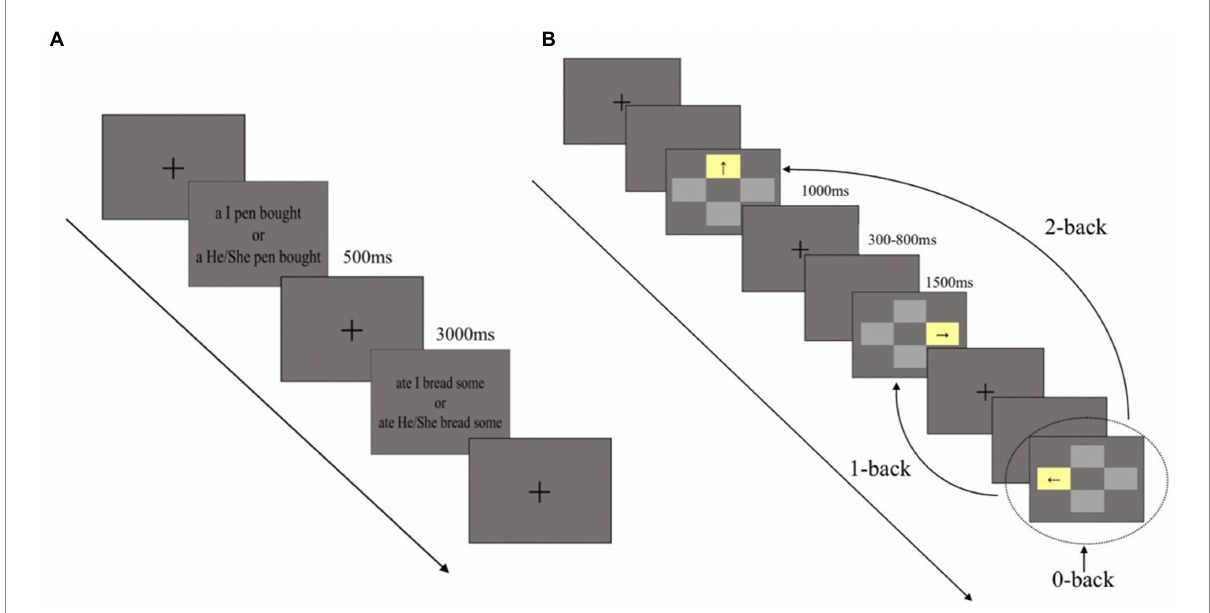
FIGURE 1 Experimental procedure and design. (A) The experimental procedure of priming self-awareness task. (B) The experimental procedure of working memory task (0-, 1-, and 2-back). Dashed circle represents the current trial, the curves indicate correct response trials in each load